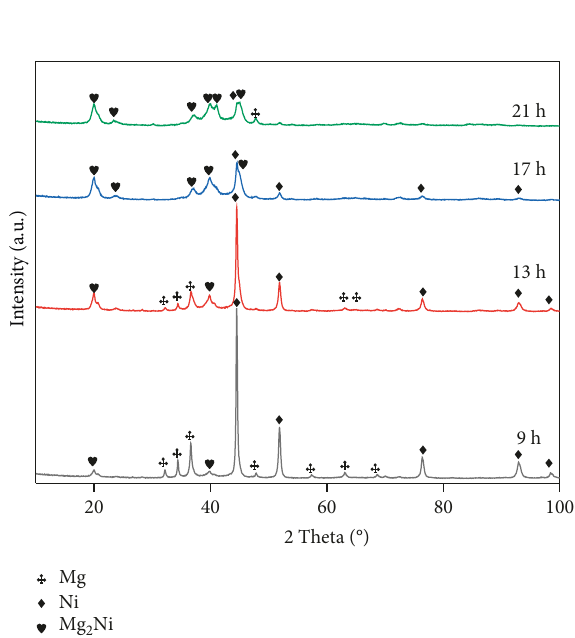
Figure 1: XRDpatternsofHCX-1ballmillat1600–1800rpm for21h, 17 h, 13 h, and 9